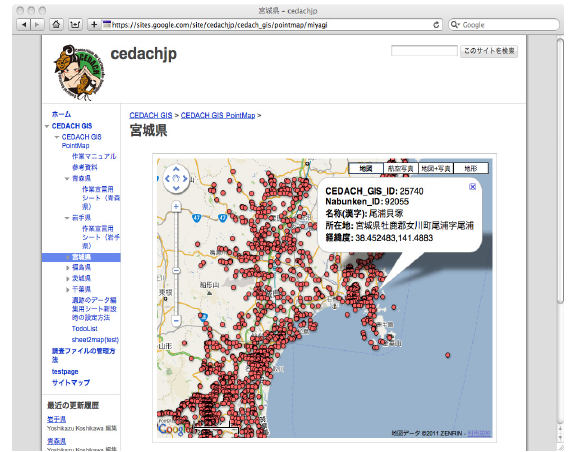
Figure 1: The interface of the CEDACH GIS